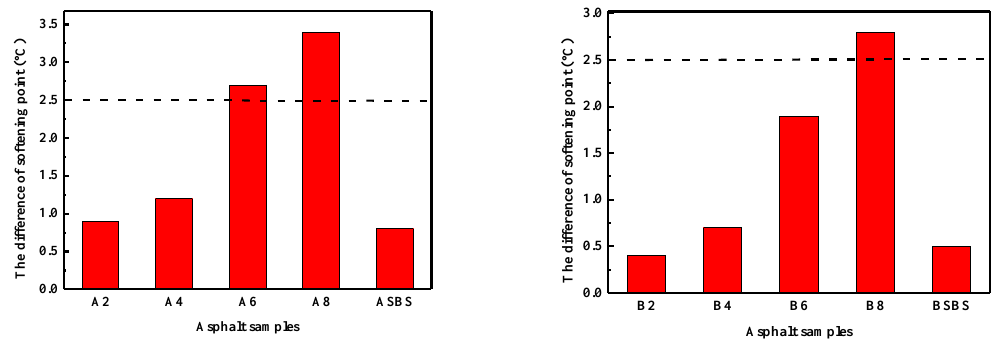
Figure 10. E ff ect of SBS latex content on the storage stability of modified Figure 10. Effect of SBS latex content on the storage stability of modified asphalts.